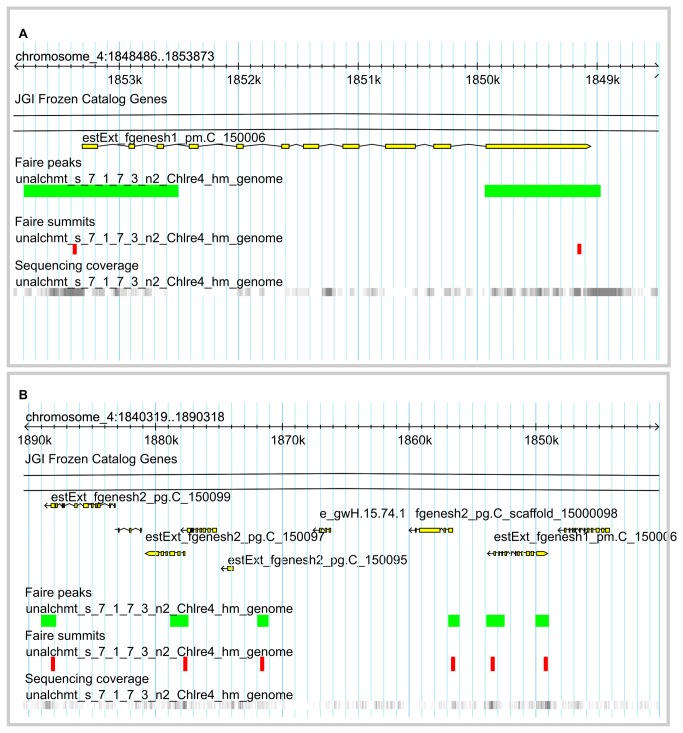
Web FAIRE-seq GenomeBrowser.FAIRE-seq reads mapped to the Chlamydomonas genome annotation v.4 were made accessible through a web GenomeBrowser (http://bce.uniandes.edu.co/gb2/gbrowse/Chlamydomonas_v4/). (A) Cah1 locus. The annotated Cah1 transcript is included; the yellow horizontal boxes indicate annotated exons and the connecting black lines indicate introns. Positions of FAIRE peaks are indicated as green horizontal bars, FAIRE summits as vertical red bars. Sequence coverage along the Cah1 locus is indicated by the gray vertical bars; the darkness of the gray bars is proportional to the abundance of the sequencing reads mapped to this particular location. (B) Broader view of the genomic location where Cah1 is annotated. Other transcripts in the proximity of the Cah1 locus are shown, together with their corresponding features.